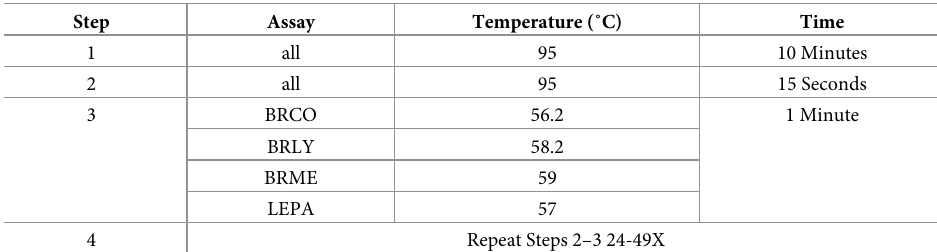
Table 2. Thermocycling conditions for each